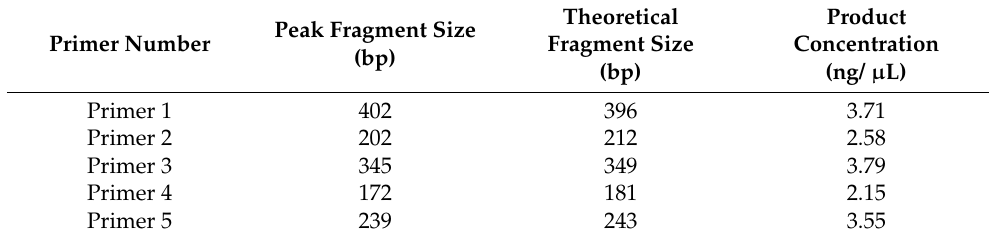
Figure 1. Capillary electrophoresis of RAA-amplified products, corresponding to five pairs of primers from ( A – E ). Five pairs of primers were used for RAA amplification; the product was ana- lyzed by capillary electrophoresis. Table 3. Amplified products use Q-sep100 detection results. Table 3. Amplified products use Q-sep100 detection results.